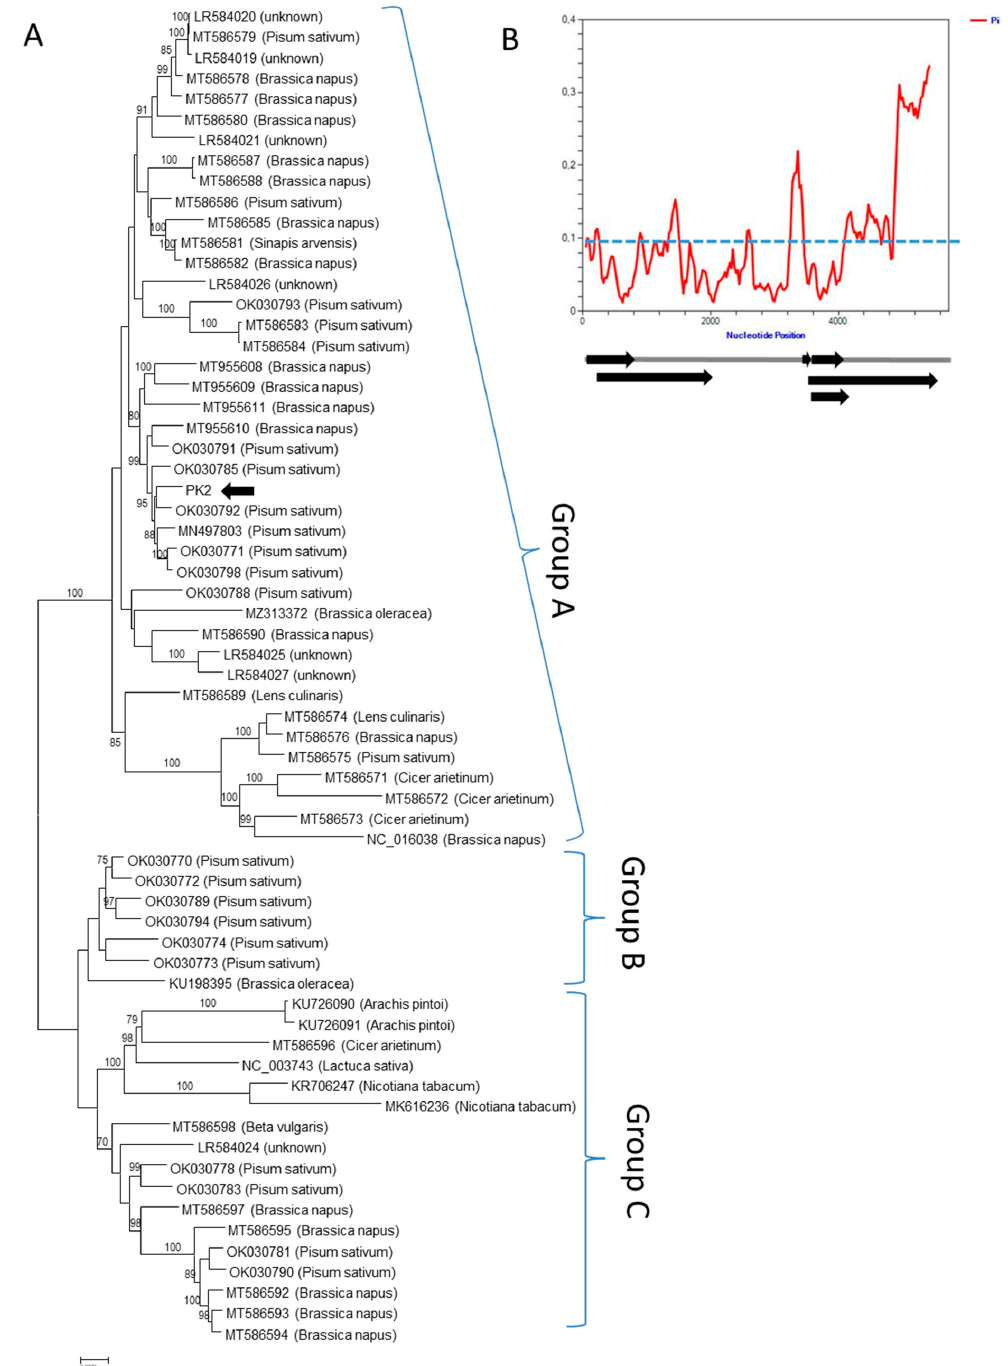
Figure 6. ( A ). Phylogenetic tree generated on available nearly complete nucleotide genome sequences of TuYV isolates ( n = 65). The phylogenetic analysis was inferred using maximum likelihood (ML) based on the General Time Reversible (GTR) model selected as the best-fit model of nucleotide substitution based on Bayesian information criterion (BIC) as implemented in MEGA X. Isolates are identified by their GenBank accession numbers and host (if known). The Slovak PK2 isolate sequenced in the present study is highlighted by an arrow. The scale bar indicates a genetic distance of 0.01. Bootstrap values higher than 70% (1000 bootstrap resamplings) are indicated. ( B ). Nucleotide diversity ( π ) plotted along the TuYV genomes with a window of 100 nt and a step of 25 nt. The blue dotted line indicates the mean nucleotide diversity ( π = 9.2%) within TuYV genomes. In scale schematic representation of TuYV genome is shown